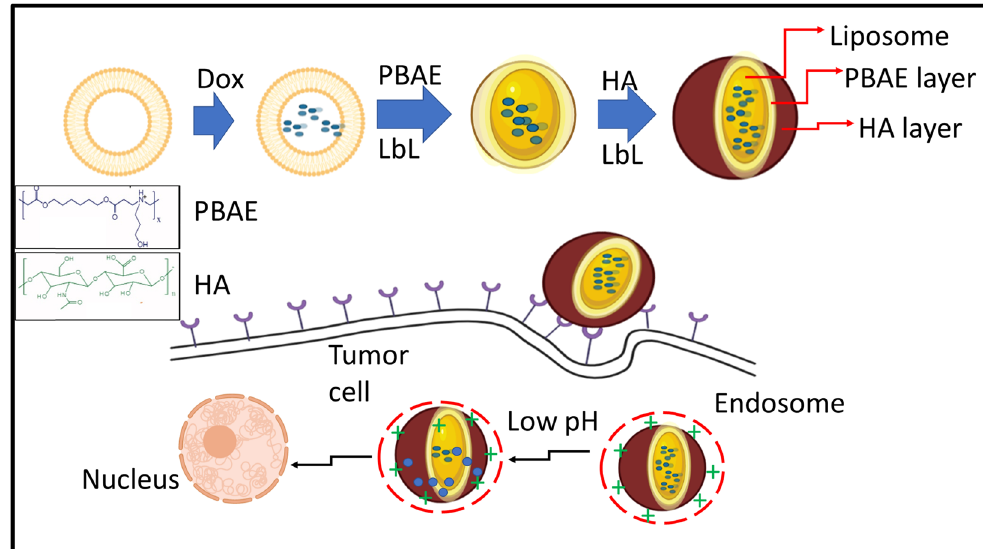
Figure 3: Schematic illustration of the development of LbL DOX - loaded NPs for targeted drug - delivery